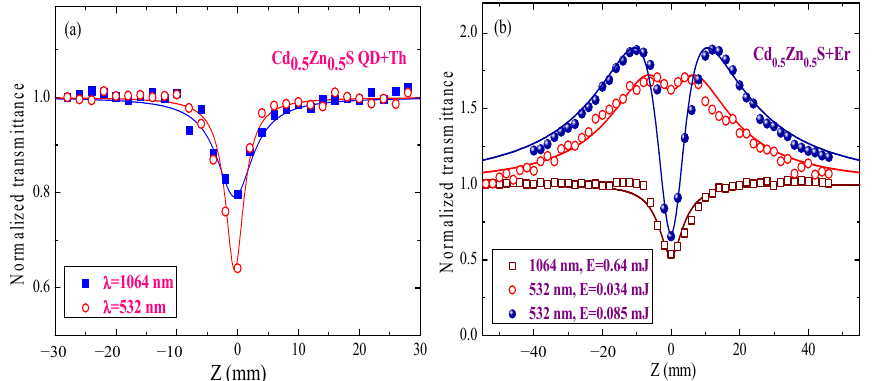
Figure 2. ( a ) Open-aperture scans of Cd 0.5 Zn 0.5 S QD+thionine suspension in the case of 1064 and 532 nm pulses. ( b ) Open-aperture scans of Cd 0.5 Zn 0.5 S QD+erythrosine suspension in the case of 1064 and 532 nm pulses. Reprinted with permission from Ref. [15], 2018, Optica Publishing Group.